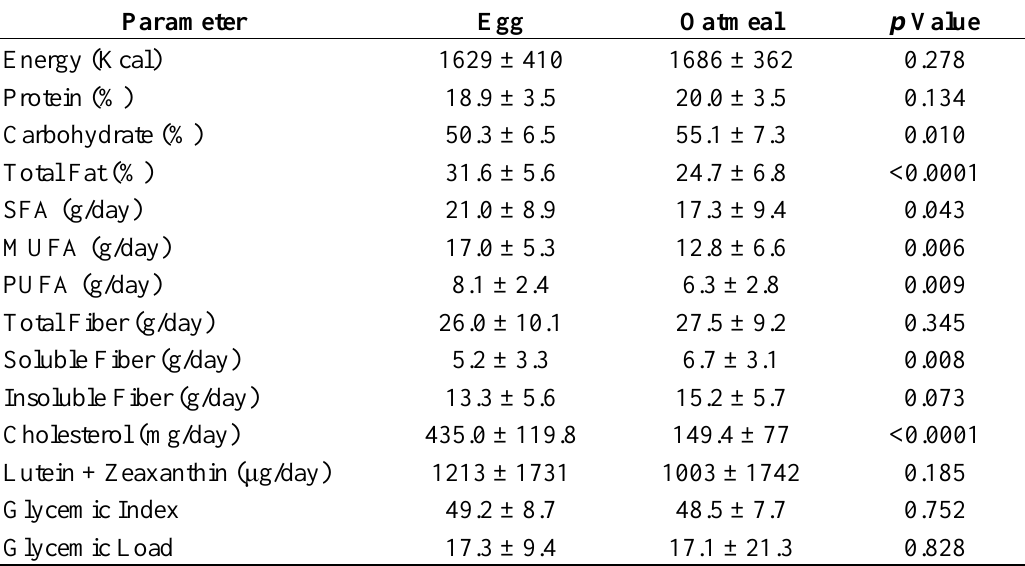
Table 2. Dietary intake during Egg and Oatmeal Periods